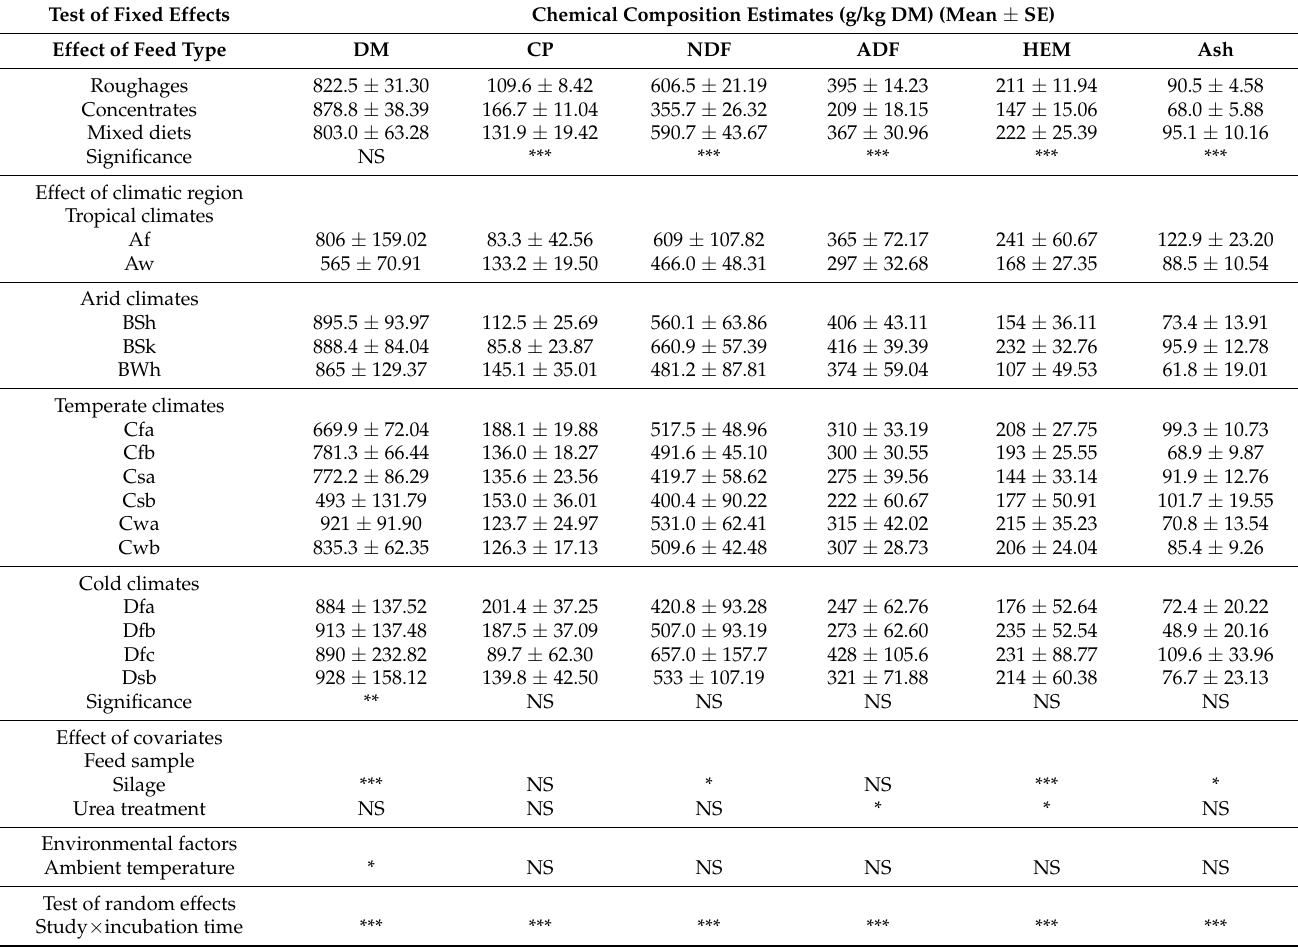
Table 8. Effects of feed type, climatic region and ambient temperature on chemical composition of feed samples incubated in the